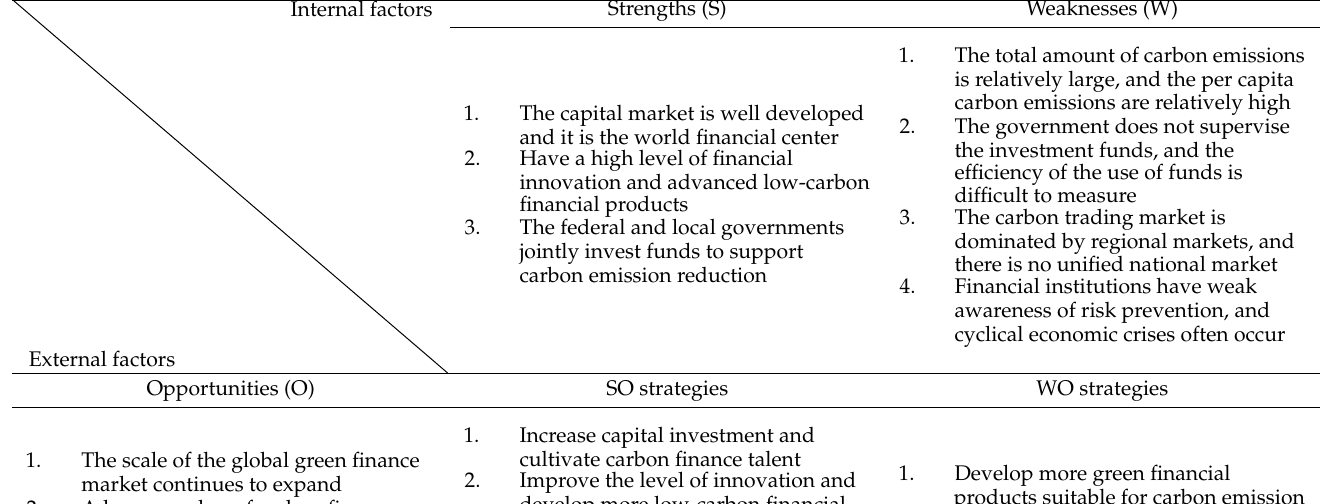
Table 3. SWOT analysis of financial measures to reduce carbon emissions in the United